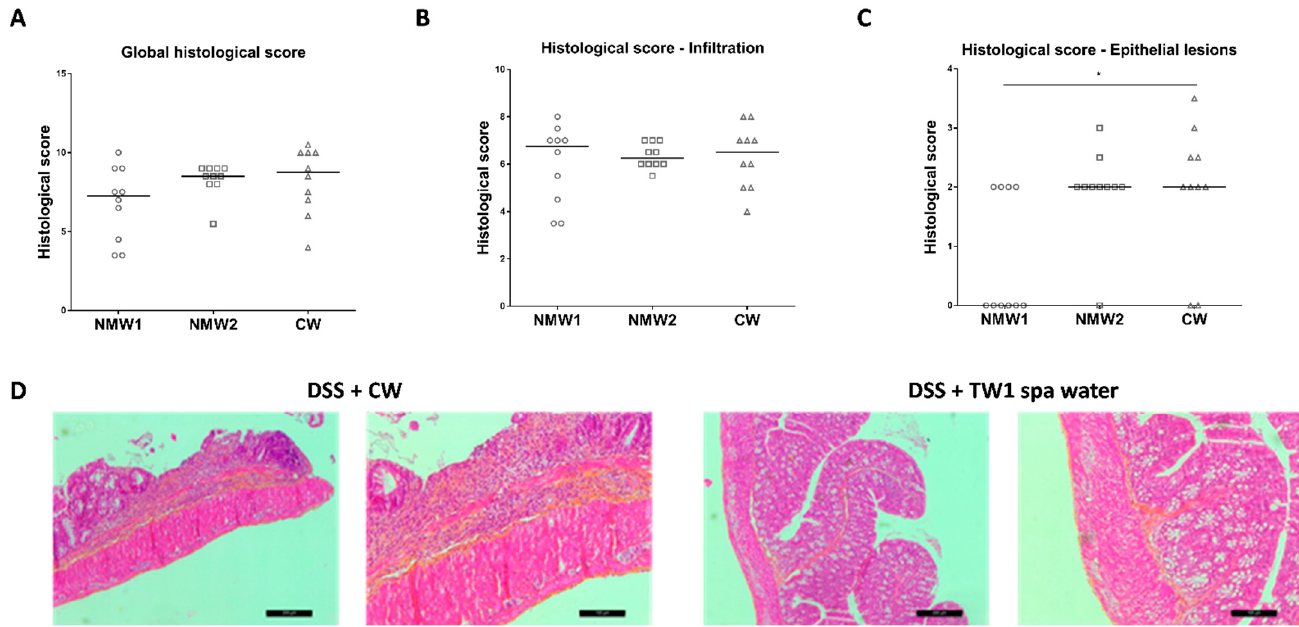
Figure 3. Effect of the administration of NMW1 or NMW2 on histological lesions. ( A ) Global histological score. ( B ) Infiltration of immune cells into the colonic mucosa. ( C ) Evaluation of epithelial lesions in the colonic mucosa. ( D ) HES staining of the colonic mucosa showing epithelial lesions (bar represents 50 µm). The results are presented as the median. Statistical comparisons were carried out after normality testing using Kolmogorov–Smirnov tests, and subsequent one-way ANOVA with the Bonferroni post hoc test was performed (* p < 0.05).